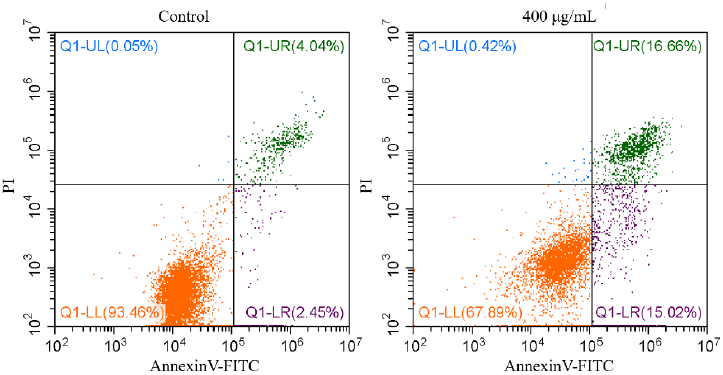
Figure 7. Representative cross quadrant images of Annexin V-FITC / PI double staining determined by flow cytometry (the summer sample).